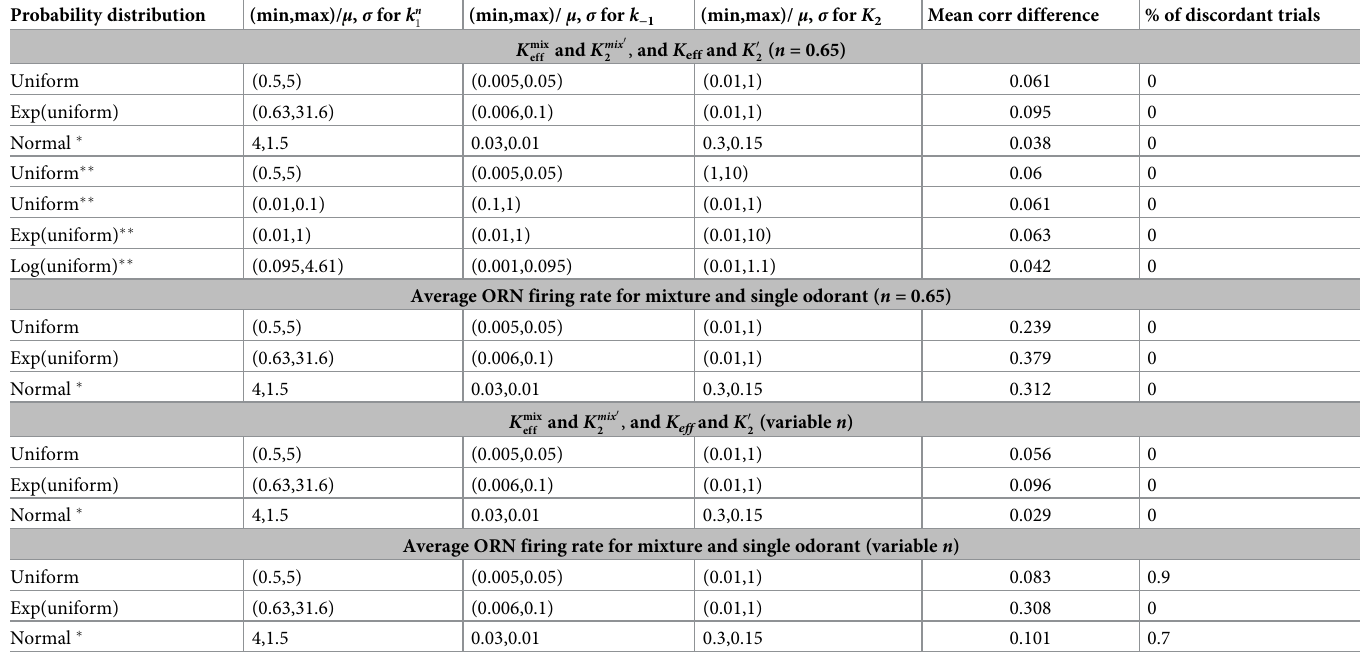
Numerical study of the difference in the mean correlation between K eff and K 0 and that of K mix and K mix 0 , and the cross-concentration ( c = 10 − 4 and c = 10 − 1 ) correlation 2 2 eff between the response patterns, in terms of firing rate, to binary mixtures and single odorants over 1000 trials. The correlation of K mix and K mix 0 is higher for all trials and 2 eff for all choices of parameter sets. The variability of the “transduction constant” n ( n 0 : log-normal distribution, μ log n 0 = 0.44, σ log n 0 = 0.22, n 0 = n log10, chosen based on experimental measurements by Gremiaux et al (2012)), weakens the effects and introduces discordance in some of the trials. However, the cross-concentration correlation of the response patterns for mixtures is still significantly higher than that of single odorants and instances of discordance are rare. The consideration of independent distributions for k n and k − 1 but not similarly for k 2 and k − 2 here is meant to introduce heterogenity to ‘stress-test’ our hypothesis. We have tried scenarios 1 where we consider distribution of K 1 as a whole, and also independent distribution for k 2 and k . The results are qualitatively the same. − 2 � A hard lower bound of 0 is imposed for unbounded